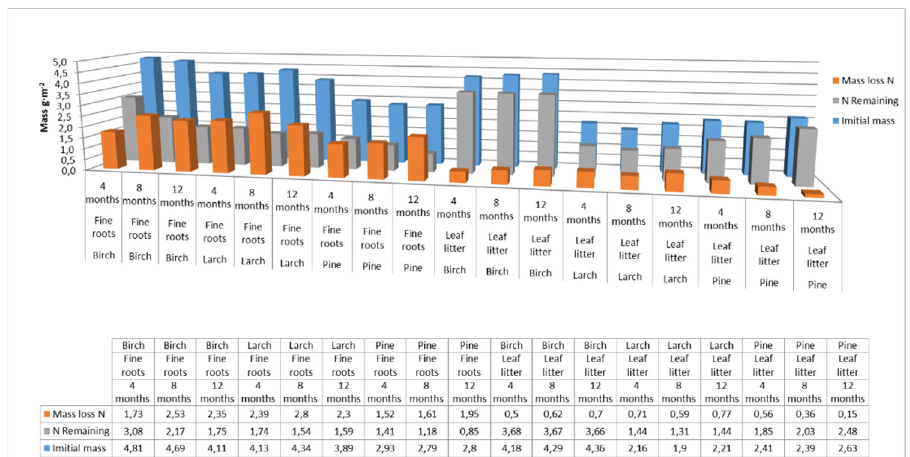
Figure 5. Nitrogen pool supplied to soils with fine roots and leaf litter at different decomposition times for different species. (Initial mass—the initial mass of nitrogen accumulated in fine roots or leaf litter at the end of the growing season; N Remaining—nitrogen accumulated in fine roots or leaf litter after 4, 8 or 12 months of decomposition; Mass loss N—loss of nitrogen from the fine roots or leaf litter after a specified decomposition time).